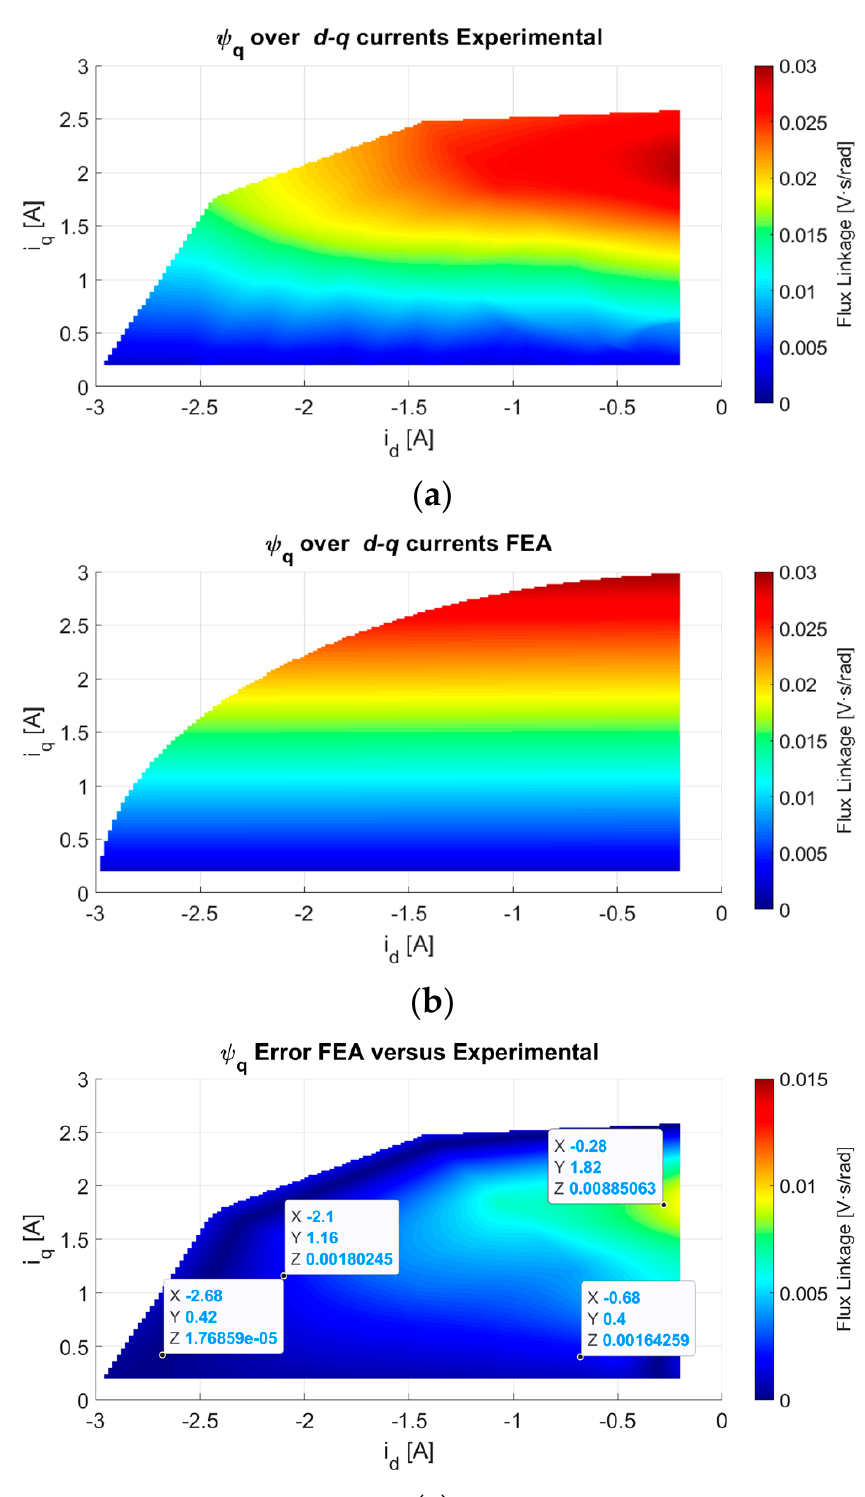
Figure 6. Quadrature flux linkage map versus d-q currents. ( a ) Parameter estimation values extracted from experimental data. ( b ) FEA values. ( c ) Absolute error between FEA and experimental maps.